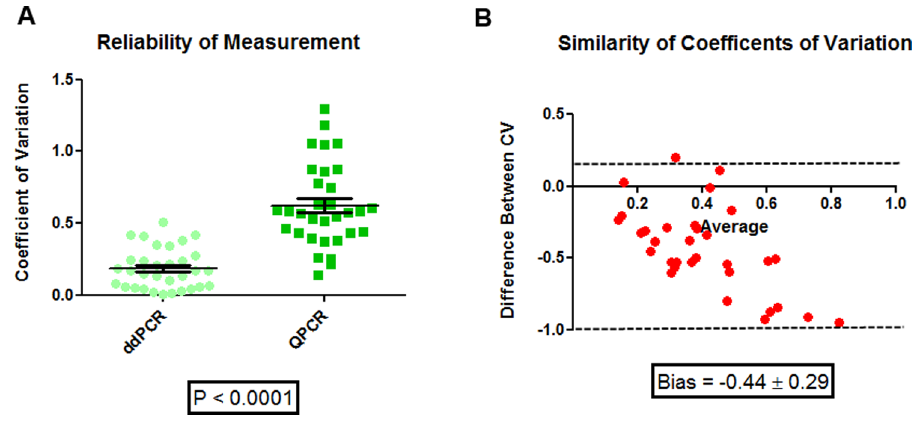
Figure 3. Comparison of the Coefficients of Variation (CV) between QPCR and ddPCR. A) Direct comparison of the ddPCR CV against the QPCR CV. The ddPCR CV was significantly lower than those obtained using qPCR. B) A Bland-Altman plot of the ddPCR CV against the qPCR CV. On average there was a much larger CV for the qPCR than the ddPCR for each individual sample of 0.44 6 0.29.